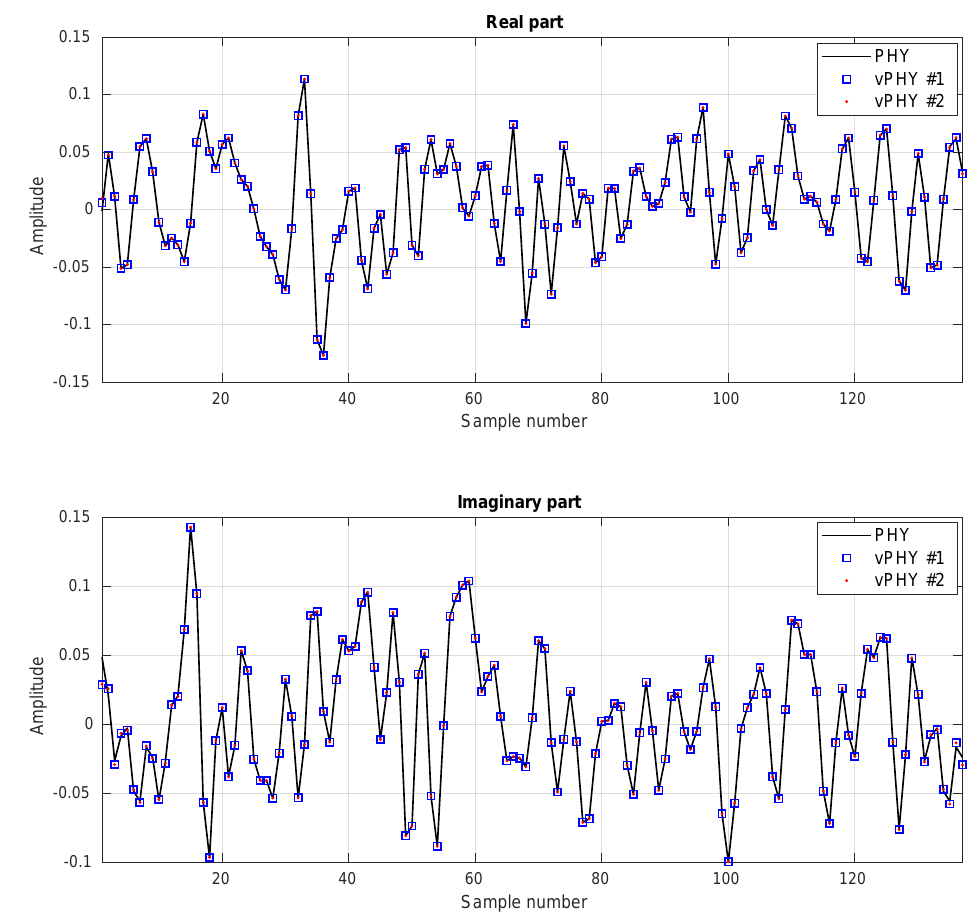
Figure 11. Comparison between OFDM symbols generated by a plain/single PHY and 2